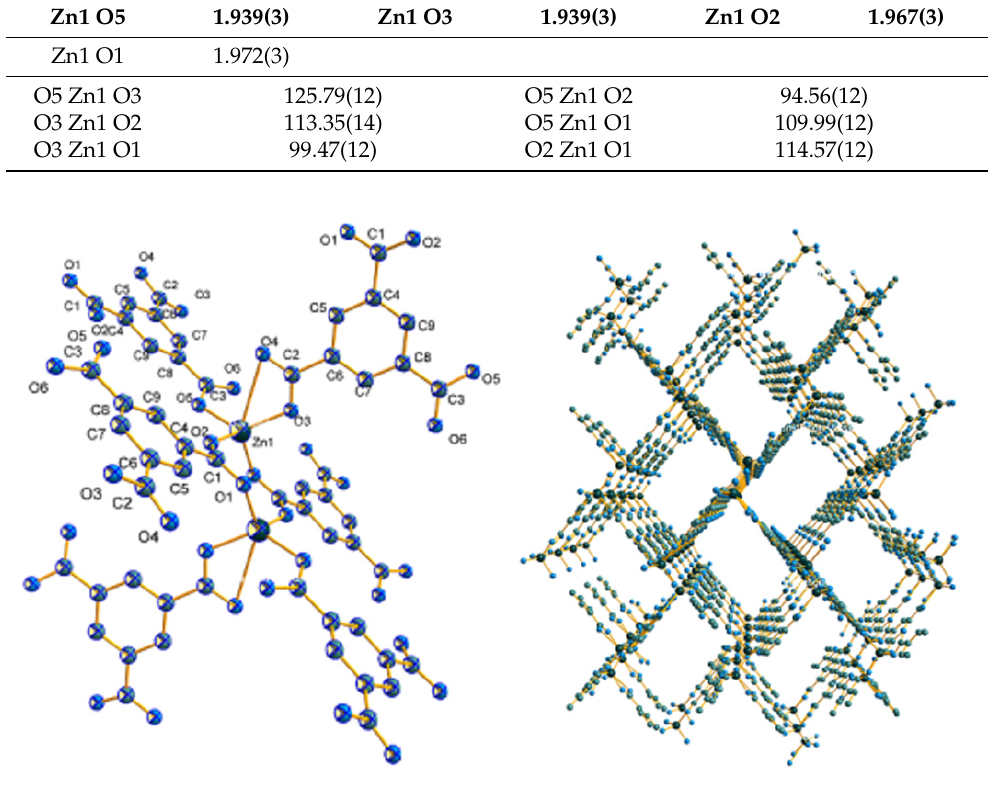
Figure 1. SBU image and 3D framework of MOF Zn(BTC) 4.